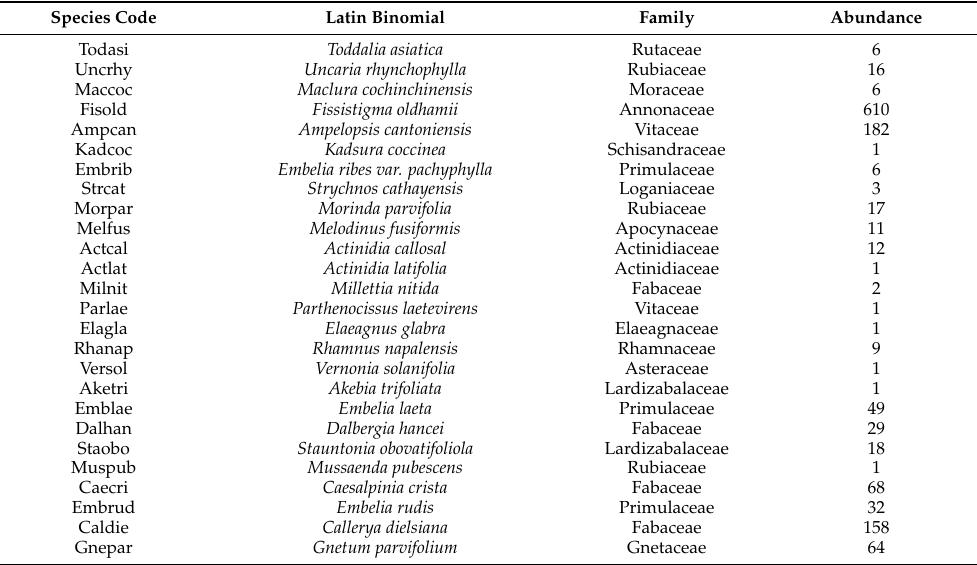
Table 1. The liana species in the 20 ha Chebaling